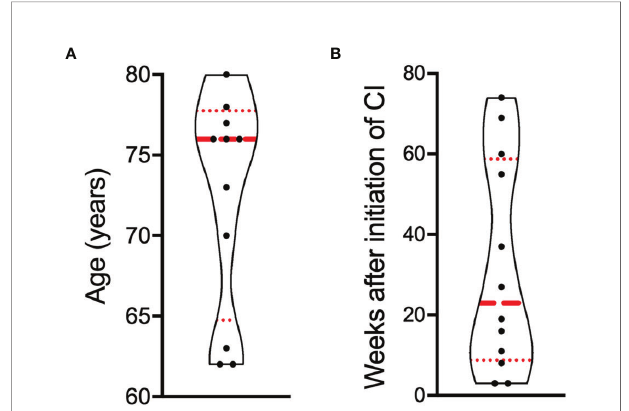
FIGURE 1 | Distribution of age and latency after the initiation of CI therapy to the diagnosis of bullous pemphigoid (BP). (A) Age of patients at the diagnosis of BP. (B) Time interval in weeks between the initiation of CI therapy and the diagnosis of BP. Results are presented as violin plot. Each dot represents one patient (n = 12). The red dashed line represents the median, the red dotted lines the 25 and 75%